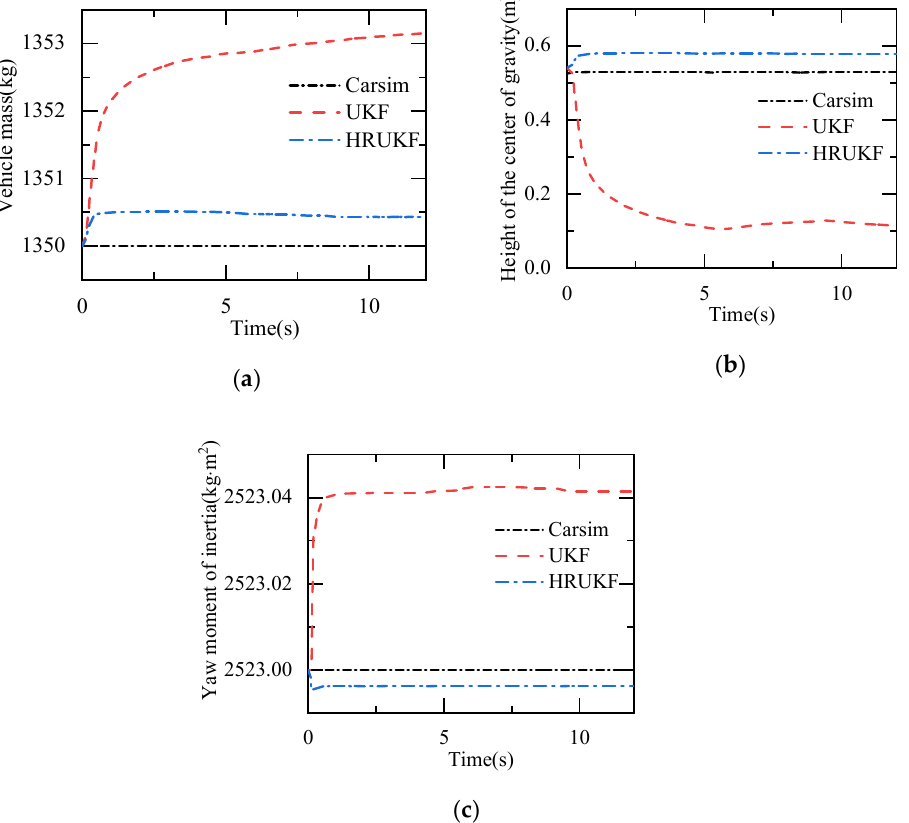
Figure 5. Observation results of vehicle parameters under double-lane change condition. ( a ) vehicle mass observation results; ( b ) height of the center of gravity observation results; ( c ) yaw moment of inertial observation results.